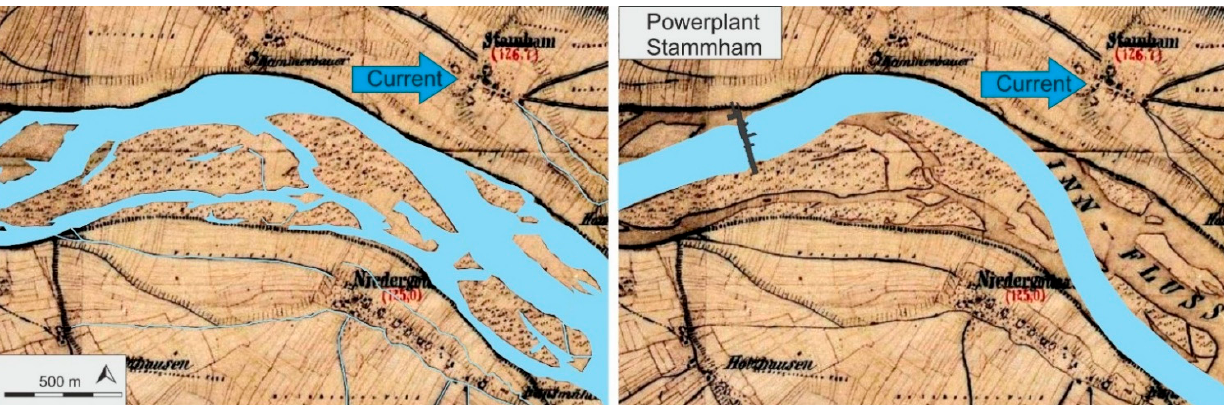
Figure 2. Illustration of the historic habitat mosaic of the River Inn comprising lentic as well as lotic habitats ( left panel ) compared the pre-restoration conditions after the implementation of the power plant Stammham in 1955 ( right panel ). The map was created based on the Bavarian “Positionsblätter”, which dates back to the 1860s (https://geoportal.bayern.de/ bayernatlas/?lang=de&topic=ba&bgLayer=historisch&catlogNodes=11,122&E=786779.49&N=5350979.79&zoom=11; last accessed on 24 March 2021). For post-restoration conditions, please see Figure